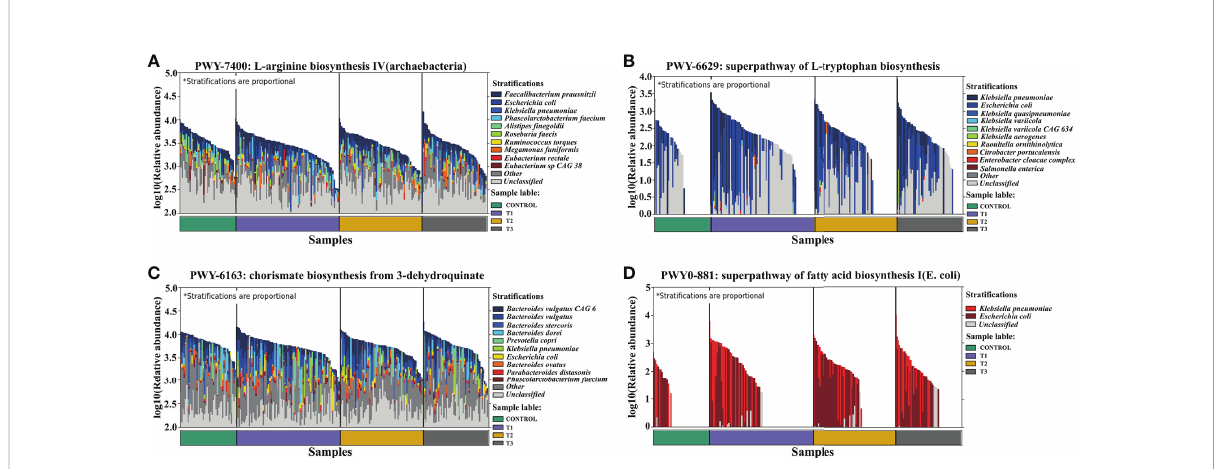
FIGURE 6 Dominant species contributing to metabolic pathways. (A) L − arginine biosynthesis IV (archaebacterial). (B) Superpathway of L-tryptophan biosynthesis. (C) Chorismate biosynthesis from 3 − dehydroquinate. (D) Superpathway of fatty acid biosynthesis I ( E. coli